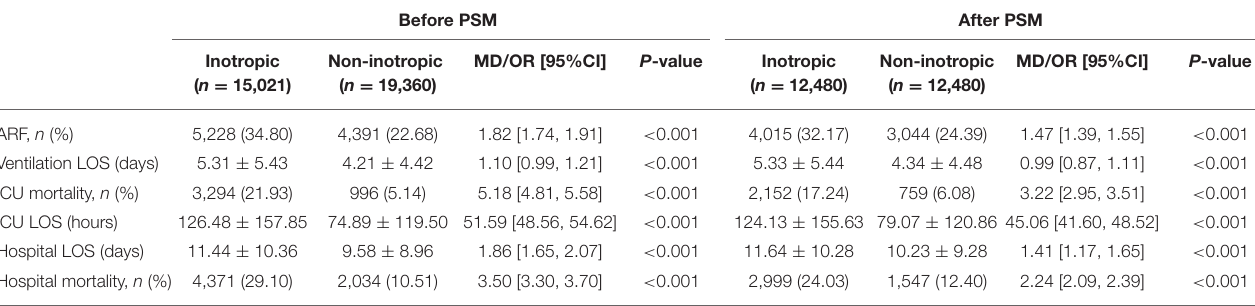
TABLE 3 | Clinical outcomes compared before and after propensity score matching between patients receiving inotropic agent and patients not receiving inotropic